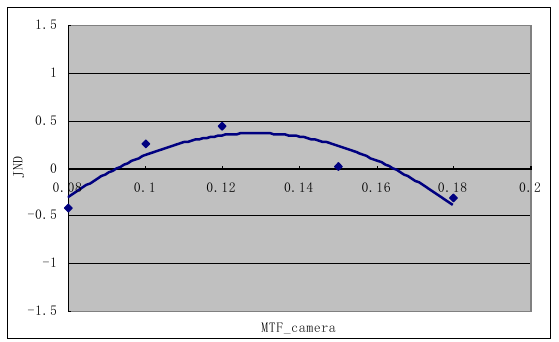
Figure 8. Influence of camera MTF to